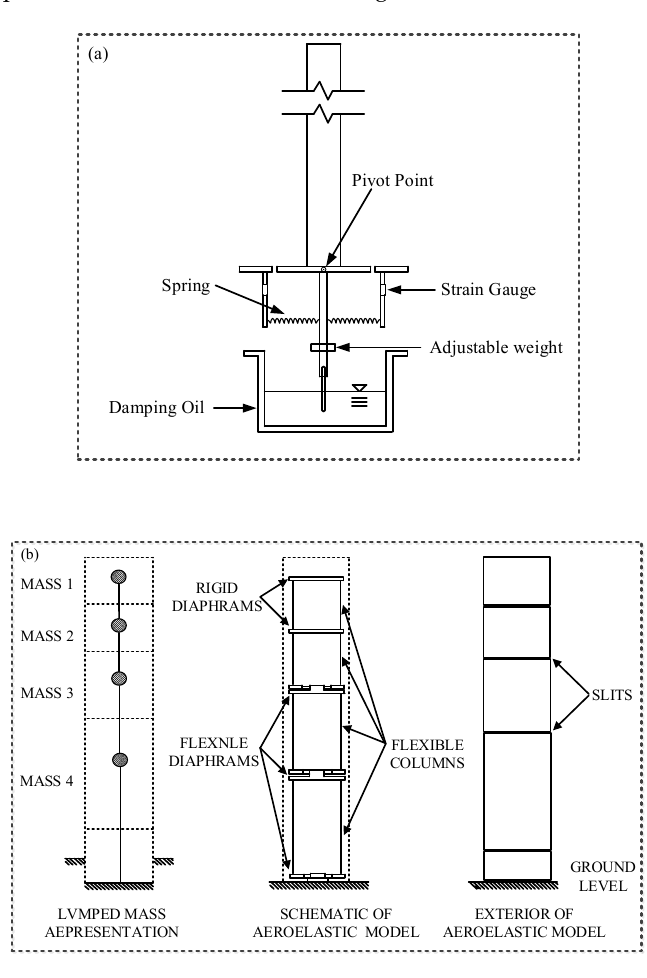
Figure 1. Typical schematic aeroelastic models: ( a ) A stick model; ( b ) a multi-degree-of-freedom model, after [26].